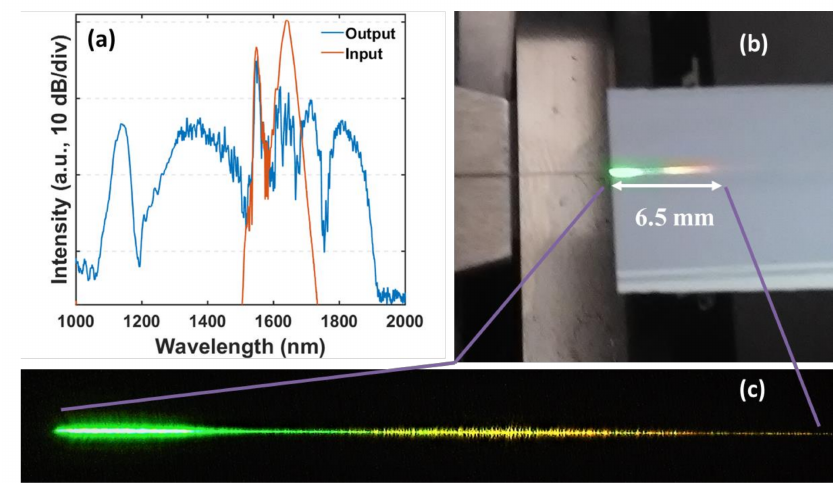
Figure 3. ( a ) Optical supercontinuum recorded at the output of the 2.2-cm-long 1.5- µ m-wide TiO 2 waveguide (blue solid line) compared to the input pulse spectrum (red solid line). The overall spectrum is reconstructed from the overlap of the spectra obtained from both optical spectrum analysers of our setup. ( b ) Photography of the visible light emitted from the waveguide. ( c ) Zoom of the emitted visible light.